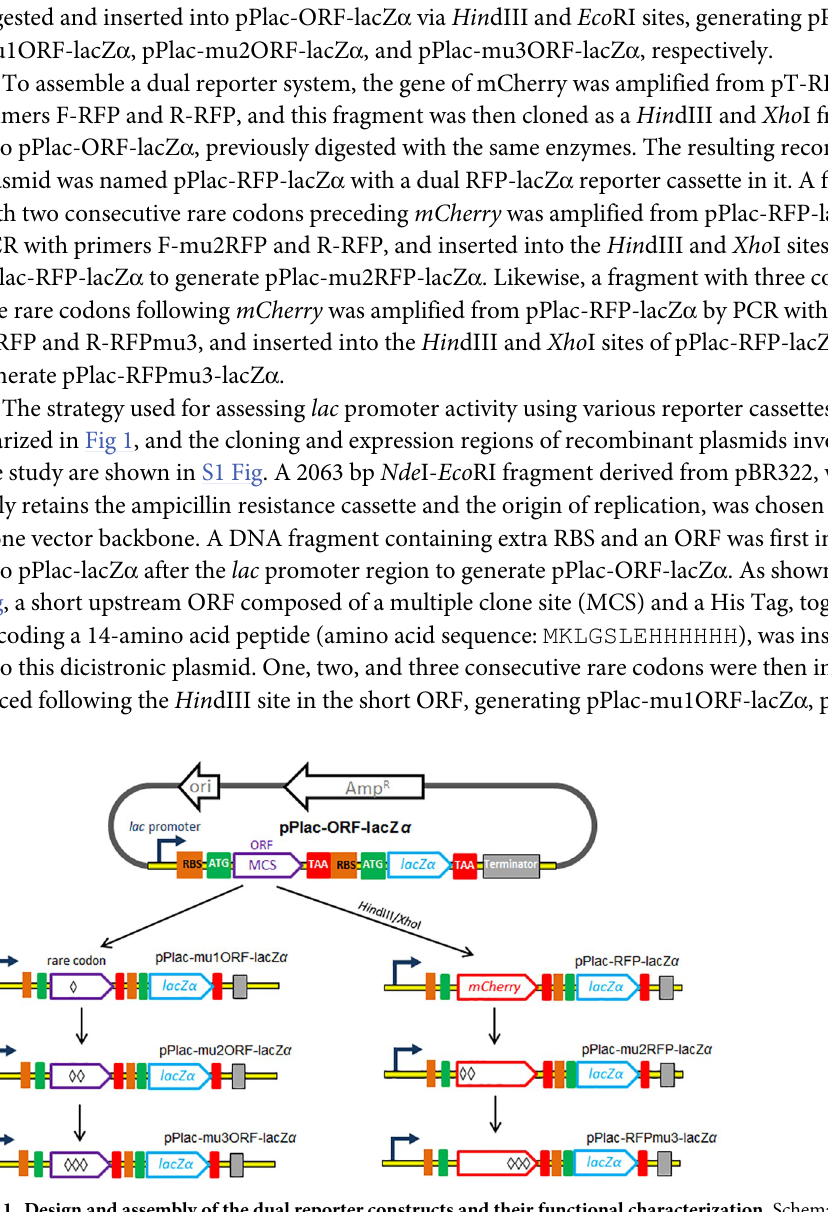
Fig 1. Design and assembly of the dual reporter constructs and their functional characterization. Schematic representation of the main features of a series of lac promoter reporter vectors, depicting the two reporters mCherry and lacZ α separated by a stop codon and an extra RBS, under the control of a lac promoter.